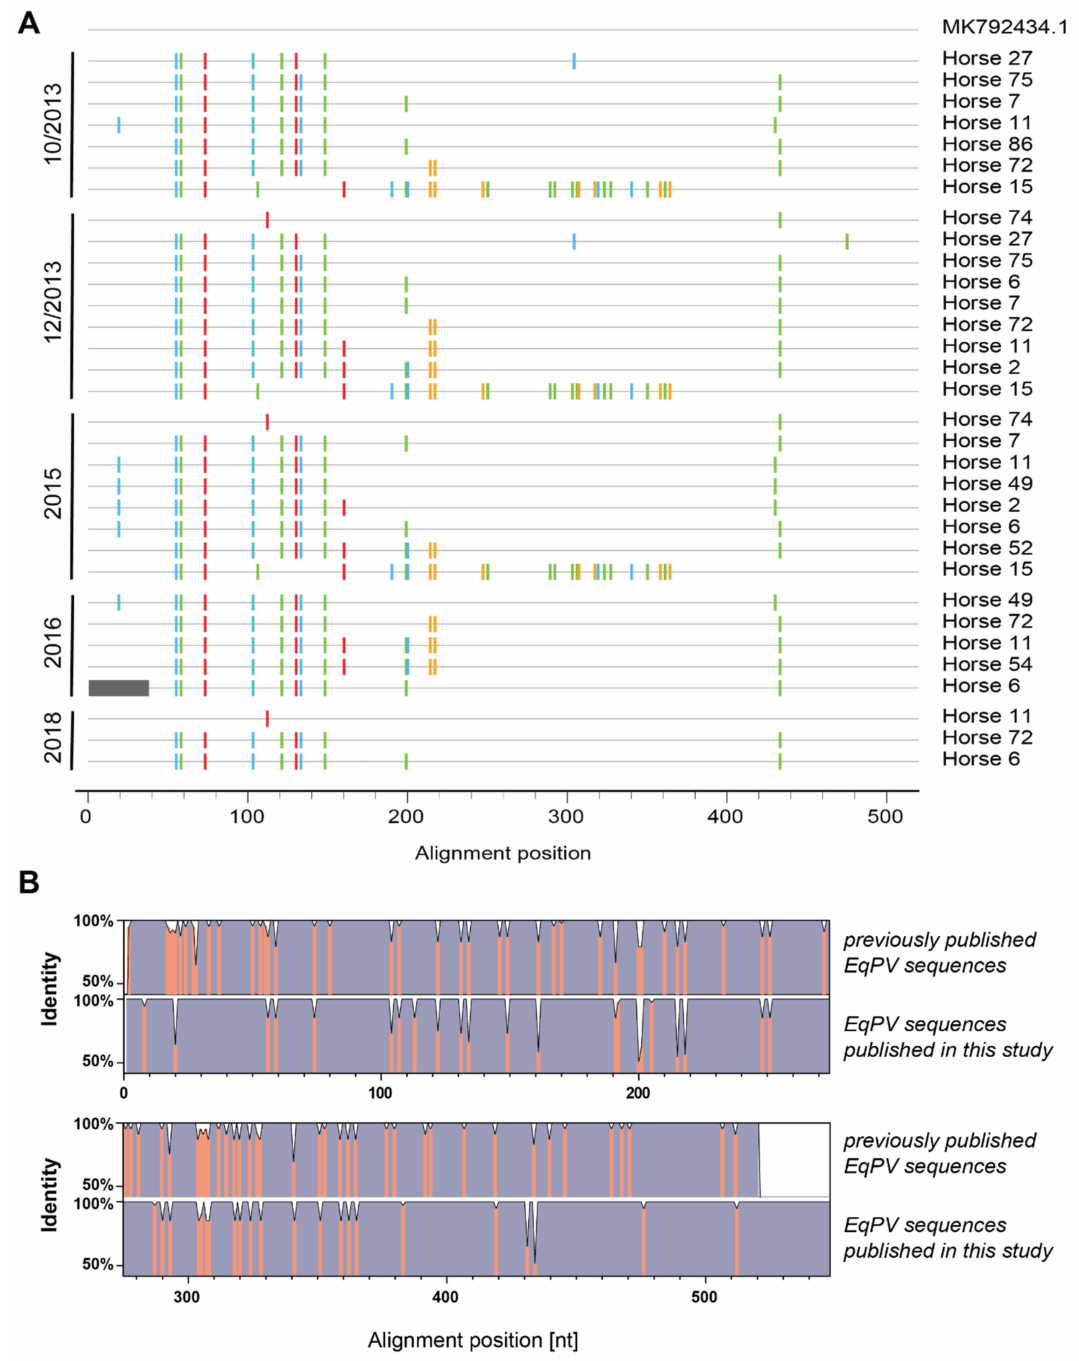
Figure 5. Sequence analysis of EqPV-H DNA positive samples. ( A ) Highlighter plot shows the nucleotide exchanges for different horses sorted by year and similarity to reference. MK792434.1, a previously published sequence from Europe, was used as reference. ( B ) Comparison of identity plots of previously published EqPV-H sequences and sequences from this study. Identity scores of respective multiple sequence alignments were obtained with Geneious 2021.1 (https://www.geneious.com, accessed on 24 June